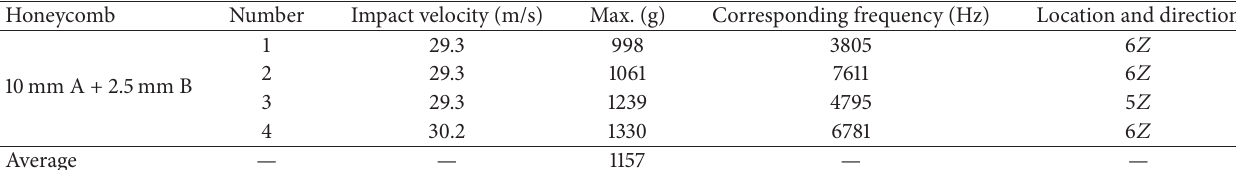
Table 4: The scatter of maximum acceleration of combined honeycombs 10 mm A + 2.5 mm B. Honeycomb